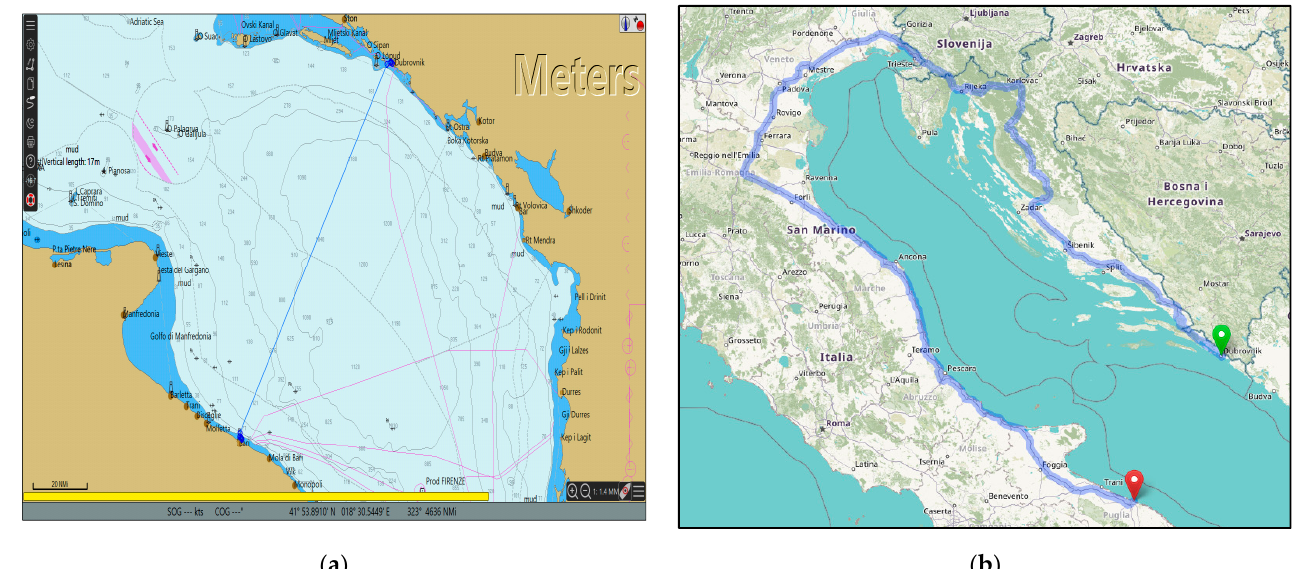
Figure 7. Route 𝑅 (cid:2871) : ( a ) maritime transportation; ( b ) road transportation. Figure 7. Route R 3 : ( a ) maritime transportation; ( b ) road Table 16. Determined distances on the route 𝑅 (cid:2871) . Maneuvering on departure Sea passage